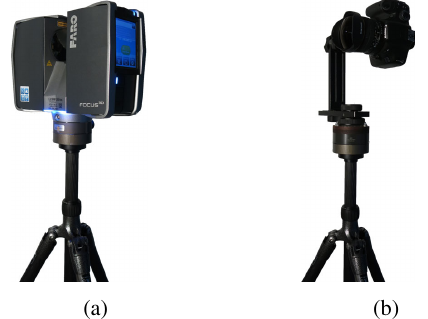
Figure 1: The data acquisition equipment: For range data acqui- sition, a Faro Focus 3D Scanner was used (a); additional color information was obtained using a customized adapter connecting the base tripod of the 3D scanner with a HDRI camera